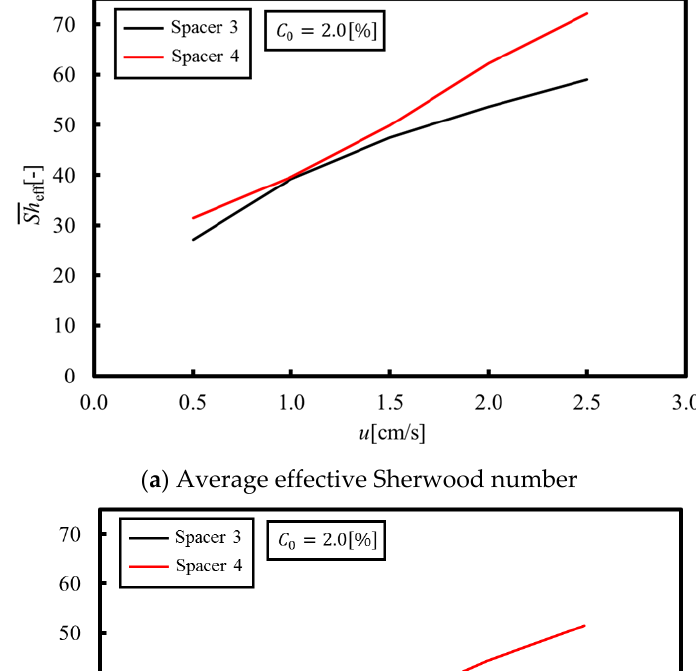
Figure 11. Effective Sherwood number distribution when using Spacer 4. The effective Sherwood number distribution is correlated with the concentration distribution on the membrane. The effective Sherwood number is high at places where the flow is disturbed around the structure, and the overall value is higher than that of the other spacers.